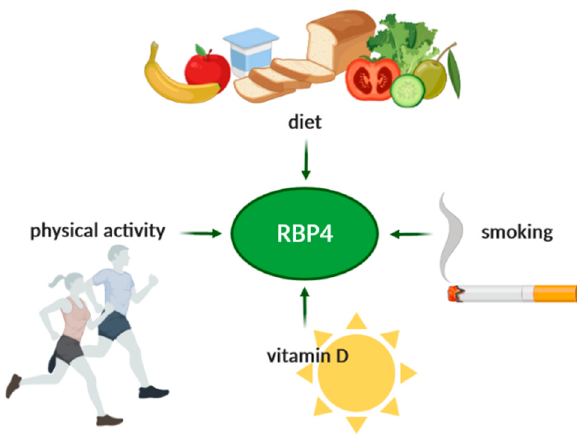
Figure 5. Diet, lifestyle, and RBP4.